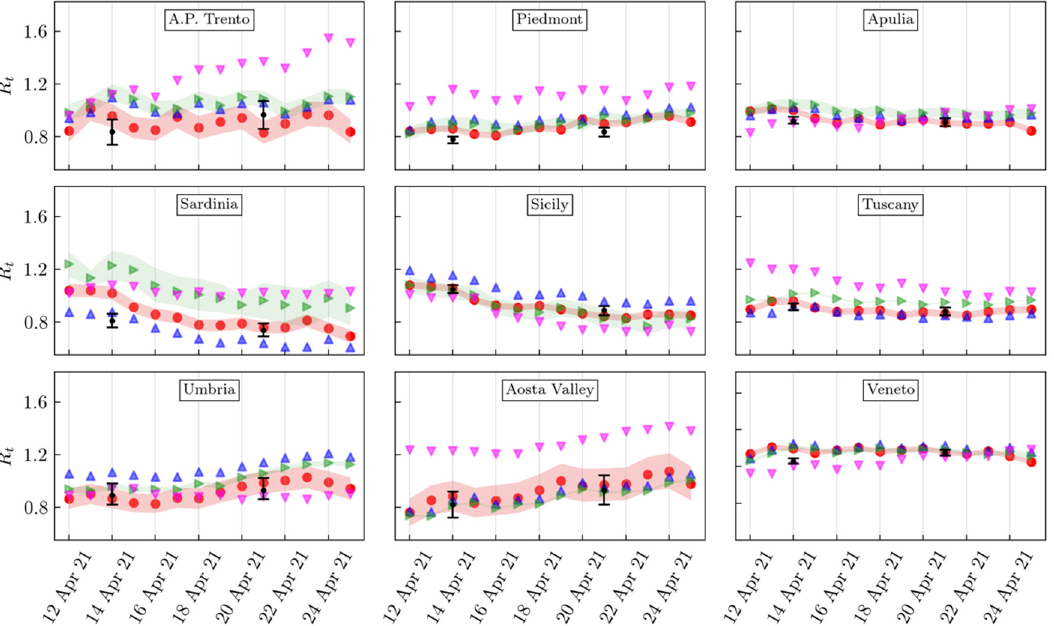
Figure 4. Effective reproduction number forecasts. R t rolling forecasts in each Italian region/autonomous province compared with the W–L R t ground truth (red circles and red region) and with the weekly ISS R t estimates (black error bars) from 12 to 25 April 2021. The regional best model predictions are represented by blue triangles, whereas the forecasts obtained from the average ensemble of the three models, which ranked in the top 3 after the K-Fold Cross Validation procedure, are reported in the magenta triangles. The 95% Prediction Interval of the best model was also reported (green triangles and green region). Table 3. Regional RMSE on the test set for the top three architectures.